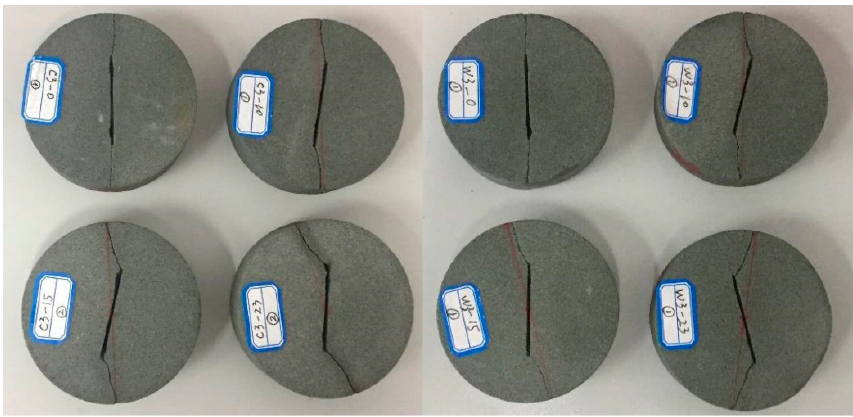
Figure 3. Failure modes of some sandstone specimens.